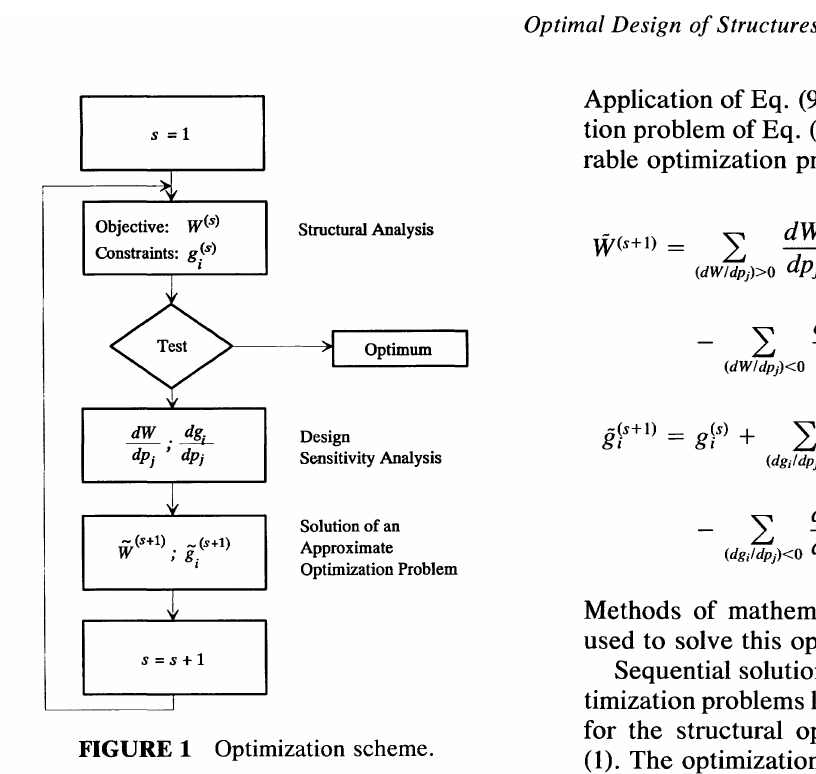
FIGURE 1 Optimization